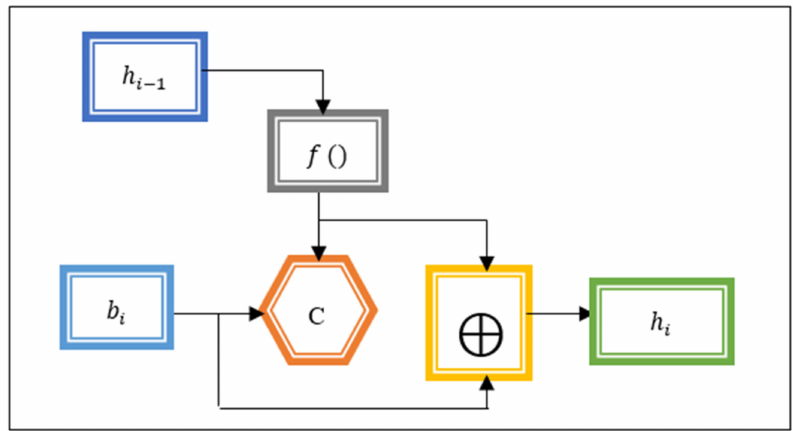
Figure 5. Operation of Miyaguchi-Preneel compression